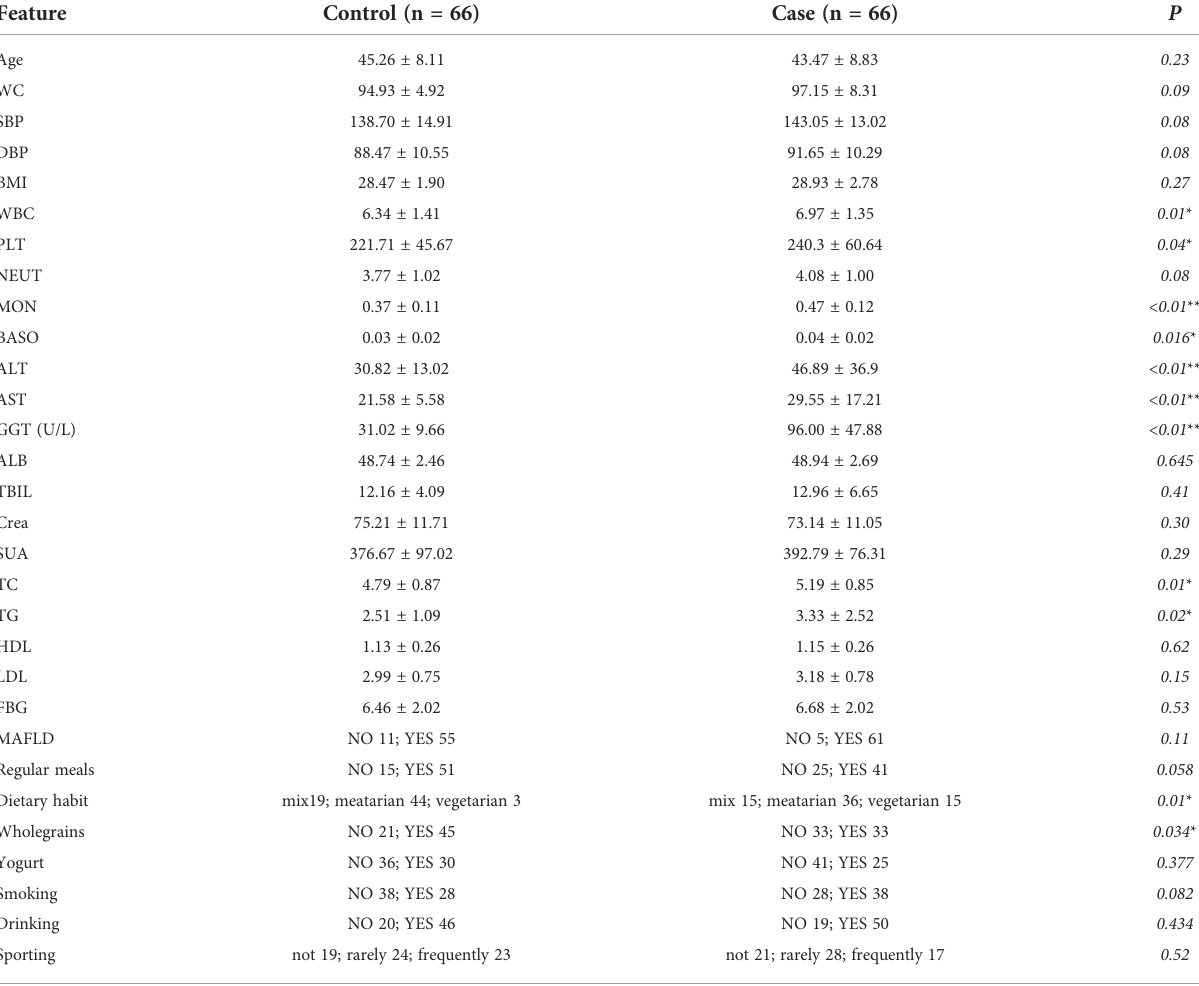
TABLE 1 The major characteristics and laboratory test results in male patients of the case and control groups.